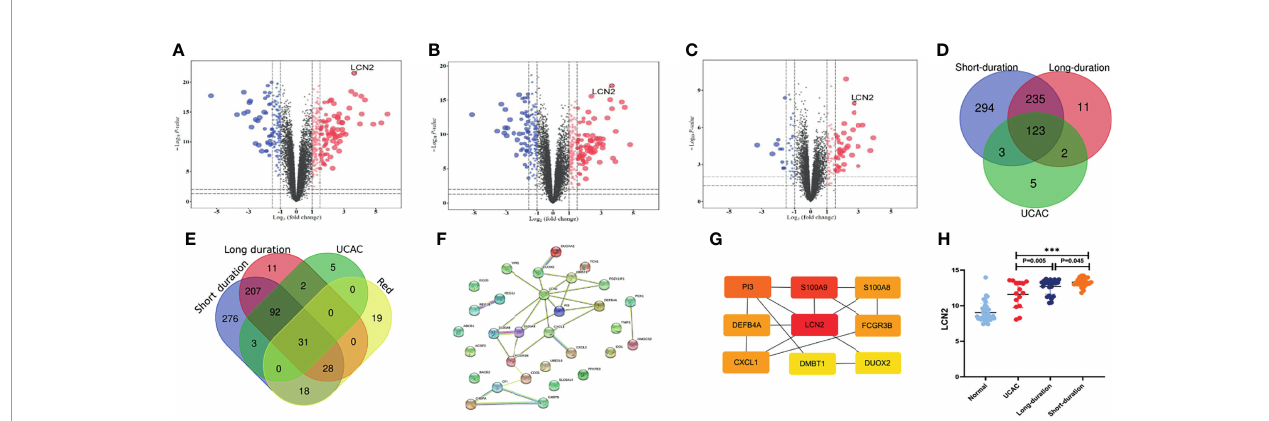
FIGURE 3 | Identi fi cation of differentially expressed genes (DEGs) among Gene Expression Omnibus (GEO) datasets. (A) Short-duration ulcerative colitis (UC) vs. normal. (B) Long-duration UC vs. normal. (C) Ulcerative colitis-associated carcinogenesis (UCAC) vs. normal. (D) Overlapping genes in UC datasets. (E) Overlapping genes in UC datasets, hub genes in red module. (F) Protein – protein interaction (PPI) network of 31 overlapping genes. (G) The top nine key genes by the maximal clique centrality (MCC). (H) Expression levels of LCN2 in UC datasets. ***P <